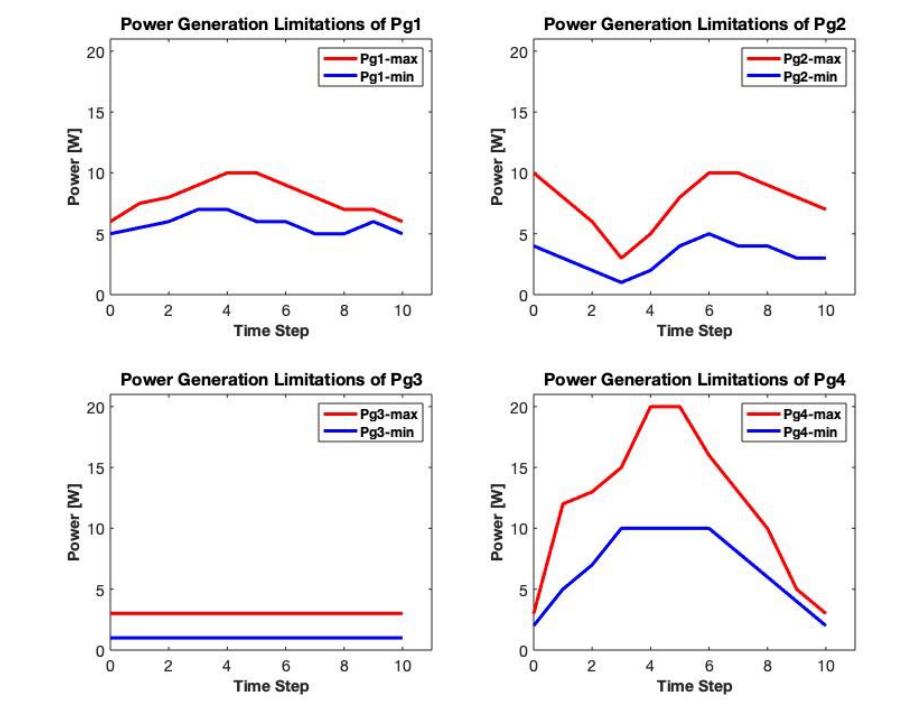
Figure 13. Power generation limitation.